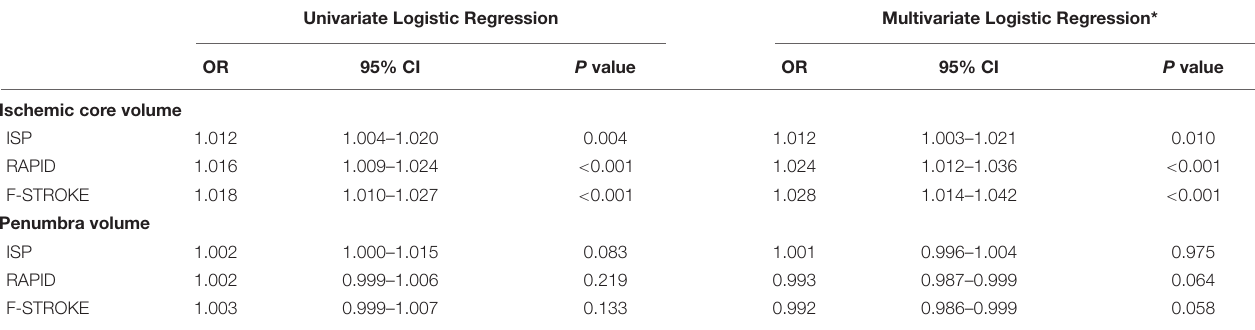
TABLE 2 | Association between CTP measurements and unfavorable clinical outcome.